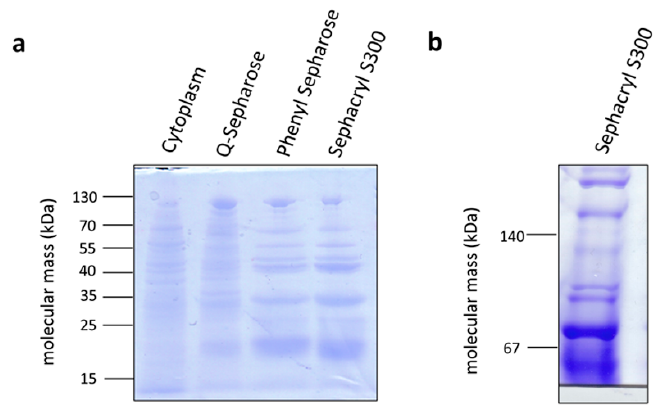
Figure 6. Enrichment of the methylene-THF reductase from C. aceticum . Samples (10 µg protein) of the cytoplasm and the purification fractions of the Q-sepharose, phenyl sepharose, and the sephacryl S300 column were separated via SDS PAGE ( a ). 10 µg of pooled active fractions of the sephacryl S300 column were also separated on a native PAGE ( b ). Gels were stained with Coomassie Brilliant Blue.